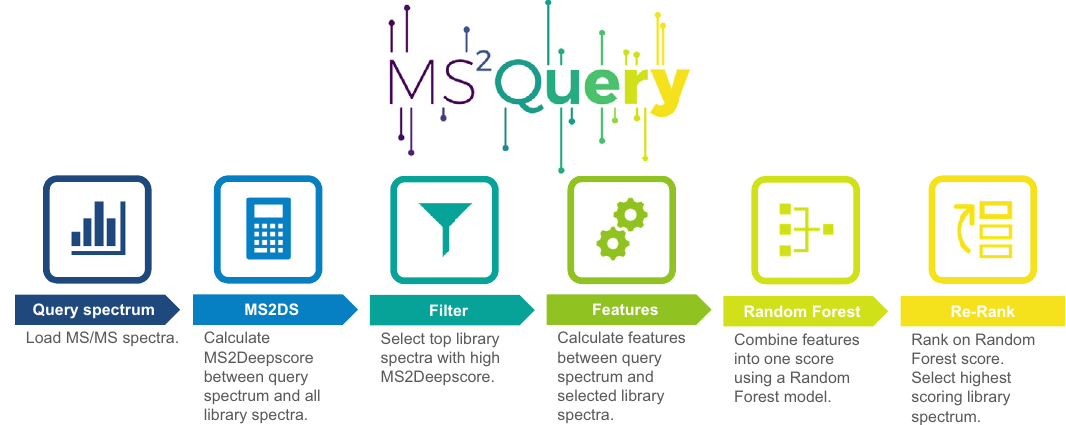
Fig.1|Schematicwork fl owofMS2Query. MS2Querysearchesforbothexactmatchesandanaloguesinareferencelibrary.First,potentialcandidatesareselectedbased on MS2Deepscore, followed by re-ranking the spectra by using a random forest